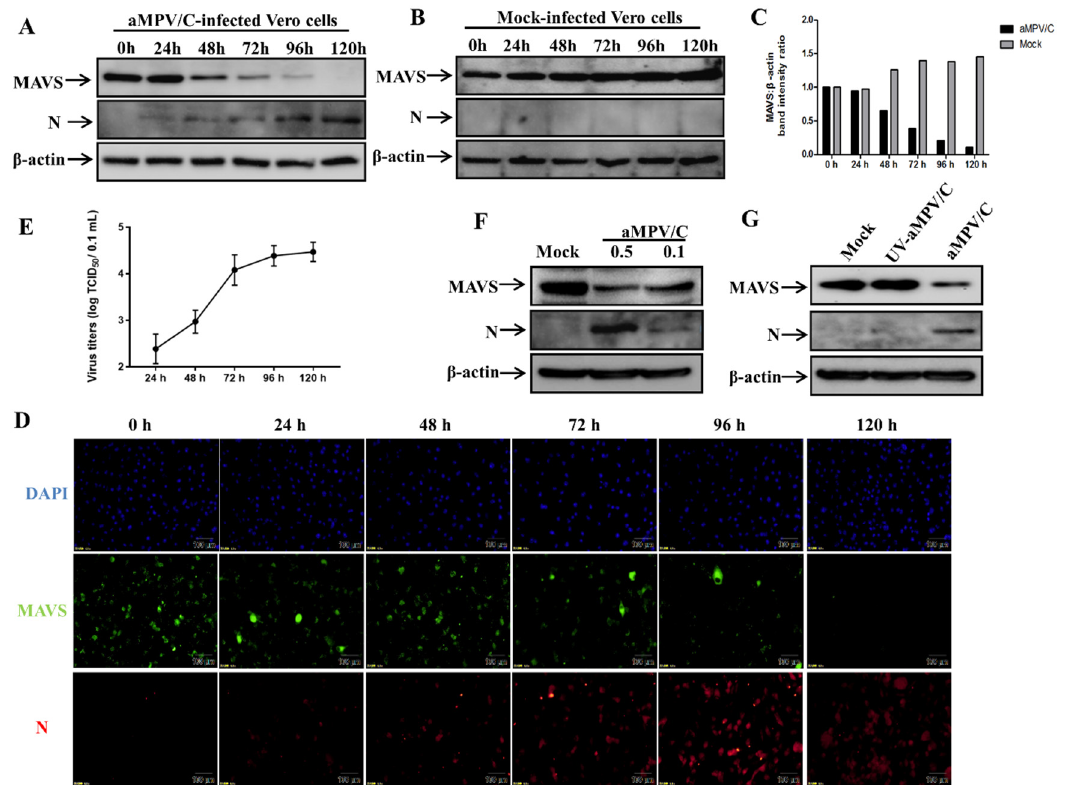
Figure 1. aMPV/C infection induces MAVS reduction in Vero cells. ( A , B ) Proteins were extracted from aMPV/C-infected or mock-infected Vero cells at 0, 24, 48, 72, 96, and 120 hpi, and were analyzed by SDS-PAGE and Western blotting with anti-MAVS and antiviral N antibodies. β -actin was used as a protein loading control. ( C ) The relative band densities of MAVS: β -actin normalized to the control conditions. ( D ) aMPV/C-infected or mock-infected Vero cells were subjected to indirect immunofluorescence analysis at 0, 24, 48, 72, 96, and 120 hpi. The MAVS expression signal (green) and viral N protein staining (red) are shown. ( E ) The growth kinetics of aMPV/C in Vero cells was assayed using TCID 50 (n = 3). ( F ) Vero cells infected with aMPV/C at an MOI of 0.1 or 0.5 were harvested at 48 hpi and analyzed by Western blotting with anti-MAVS, antiviral N, and anti- β -actin antibodies. ( G ) Vero cells were infected with aMPV/C or UV- aMPV/C (MOI = 0.5) for 48 h. Subsequently, proteins were extracted and analyzed as described in A and B.